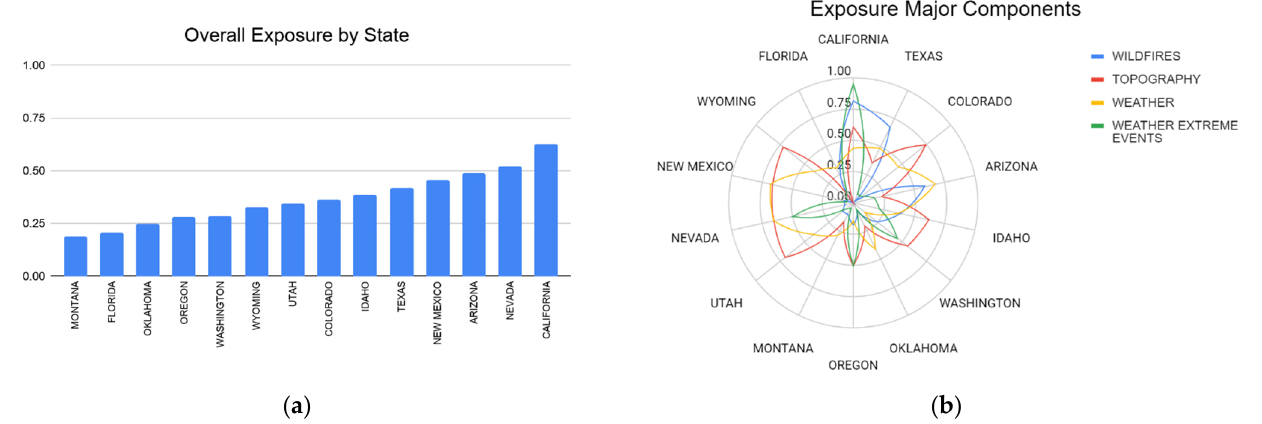
Figure 5. Histogram showing the overall exposure of the 14 selected states in the US with California having the highest exposure (with respect to wildland fire) and Texas having the lowest overall exposure ( a ). Radar plot showing the different major components of the exposure contributing factor, namely, wildfires (blue), topography (red), weather (yellow), and weather extreme events (green) for the selected 14 states of the US ( b ).